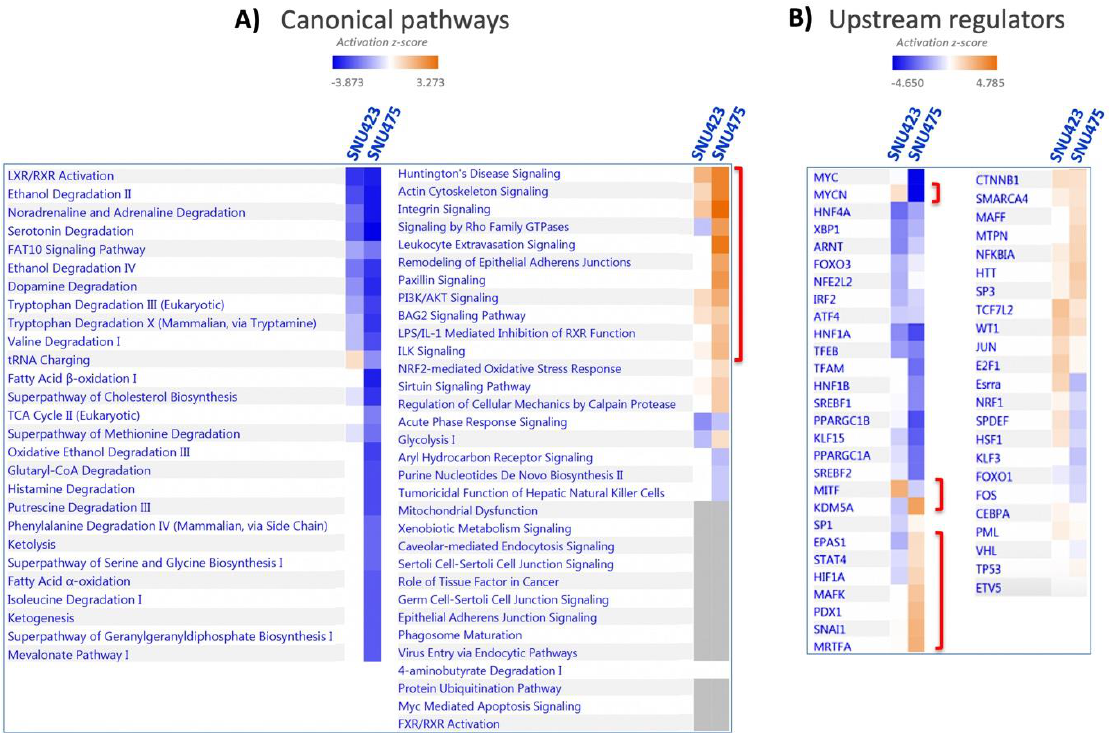
Figure 2. Systems Biology analysis of differential proteomic data from three HCC cell lines. Quantitative data on protein levels in SNU423 and SNU475 cells relative to the levels in HepG2, the more differentiated cell line, were analyzed. Up- and down-regulated proteins were analyzed using the IPA software in terms of ( A ) canonical pathways based on the content of the Ingenuity Knowledge Base, and ( B ) Upstream Regulator Analysis to identify the cascade of upstream transcriptional regulators (see M&M section 2.7 for more details). The degree of activation is represented in a color scale as indicated. Red brackets have been added to highlight significant data commented on in the main text.